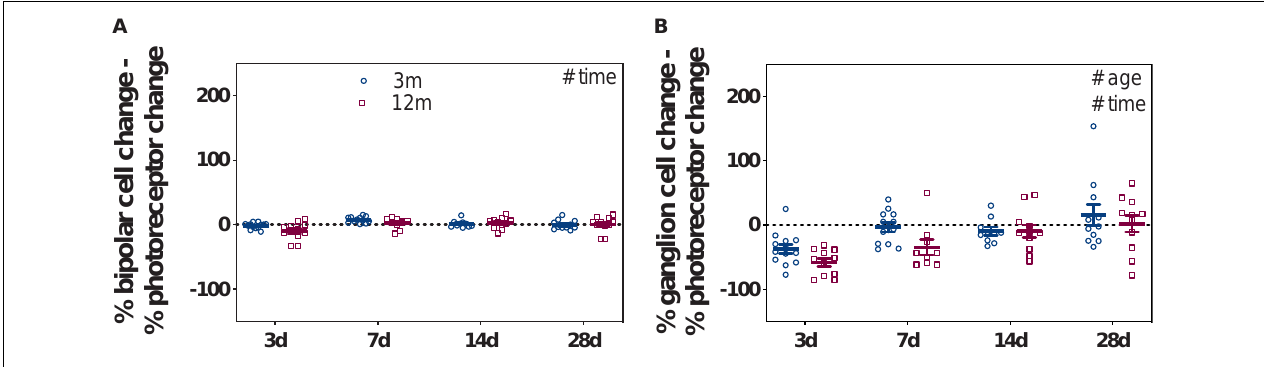
FIGURE 2 | Bipolar cell and ganglion cell responses expressed relative to their own photoreceptor input. Responses from IOP-treated eyes were expressed relative to their contralateral control eyes (%). (A) For each eye, the % photoreceptor response was subtracted from % bipolar cell response. This normalizes the bipolar cell response to their photoreceptor input. (B) For each eye, the % photoreceptor response was subtracted from % ganglion cell response. This normalizes the ganglion cell response to their photoreceptor input. A resultant negative % difference indicates that ganglion cell function was more affected than expected from